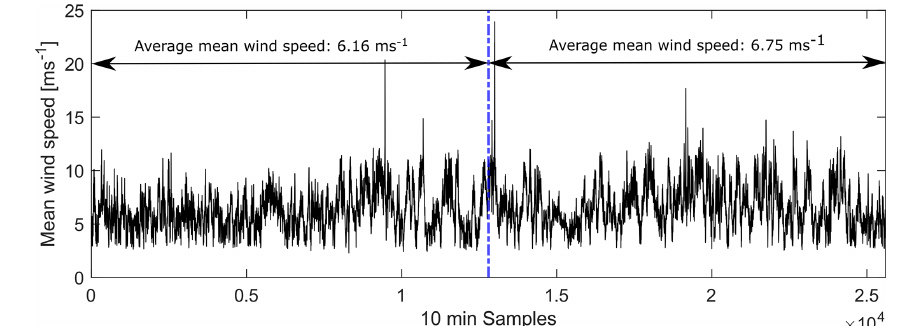
Figure 9. Mean wind speed during partial